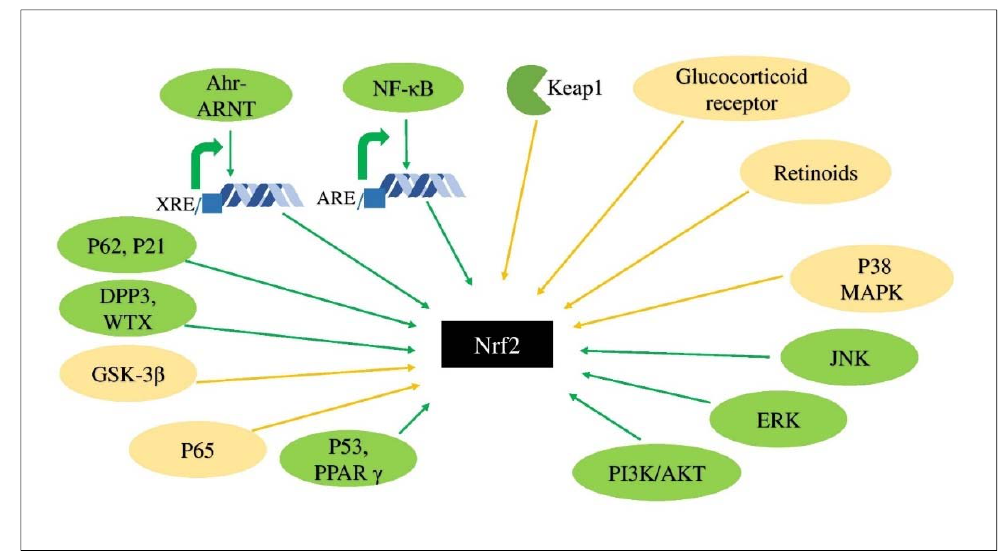
Figure 4. Various factors participate in Nrf2 regulation. The yellow color suggests the suppression of Nrf2 expression and the green color suggests the elevation on Nrf2 expression. The diagram was adapted and modified from Basak, P. et al., 2017 [56].